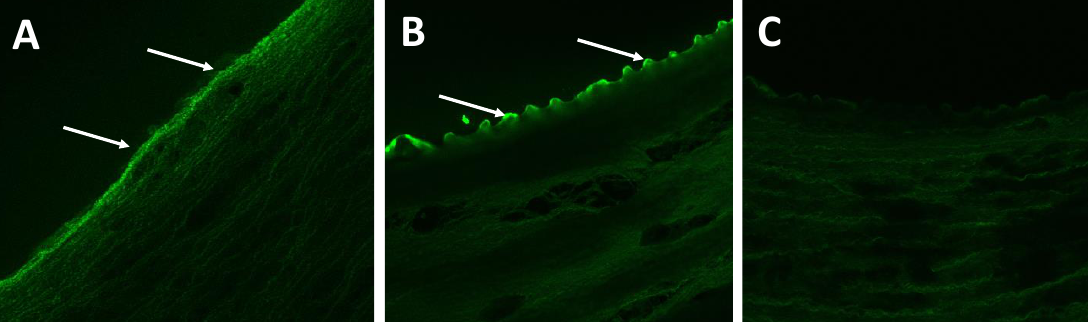
Figure 4. Representative confocal images arterial segments following keratose delivery. Confocal microscopy confirmed the presence of the keratose at ( A ) 1 h and ( B ) 3 days under peripheral deformation conditions. ( C ) Negative control depicts the lack of tissue autofluorescence during confocal imaging.